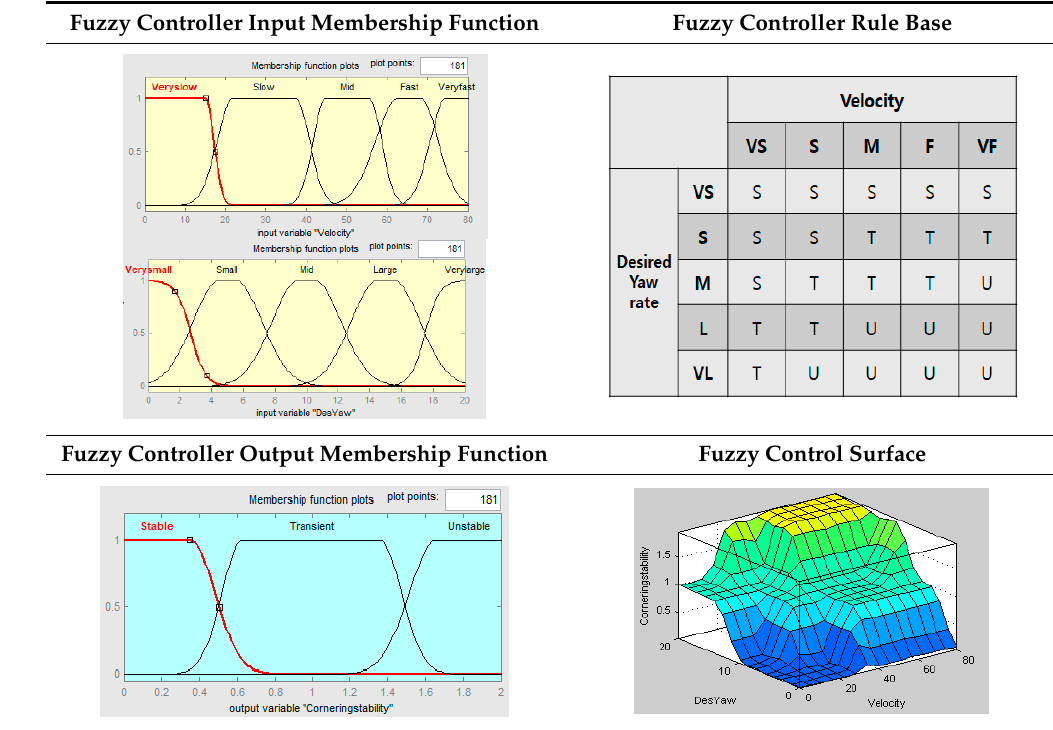
Figure 6. Operating region of acitve yaw rate control.